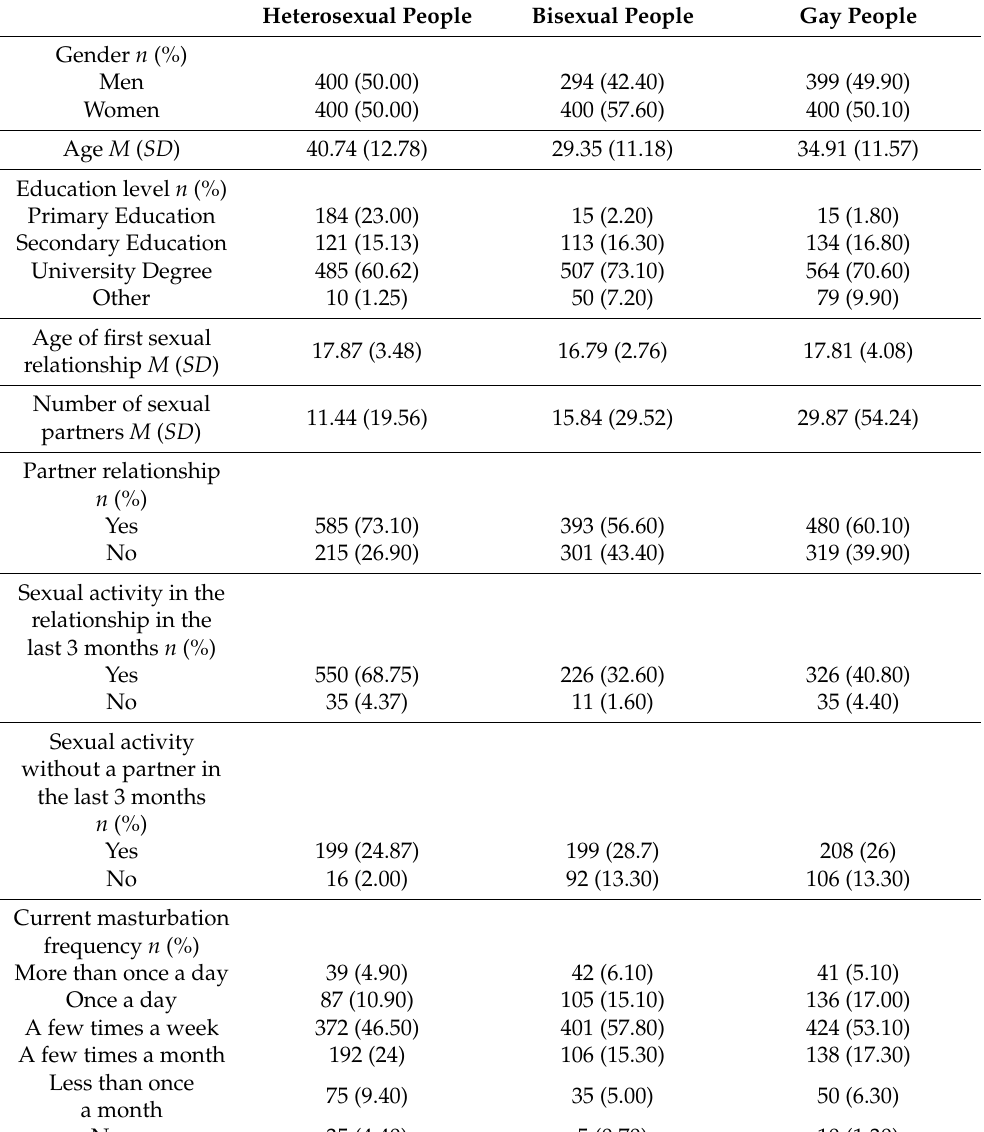
Table 1. Sociodemographic characteristics of the sample by sexual orientation. Heterosexual